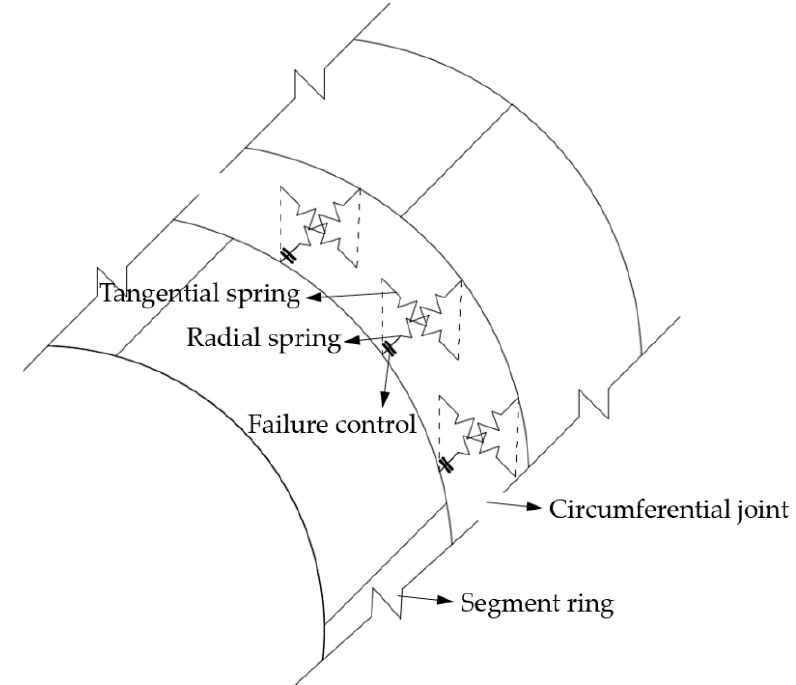
Figure 7. Schematic diagram of connector unit.